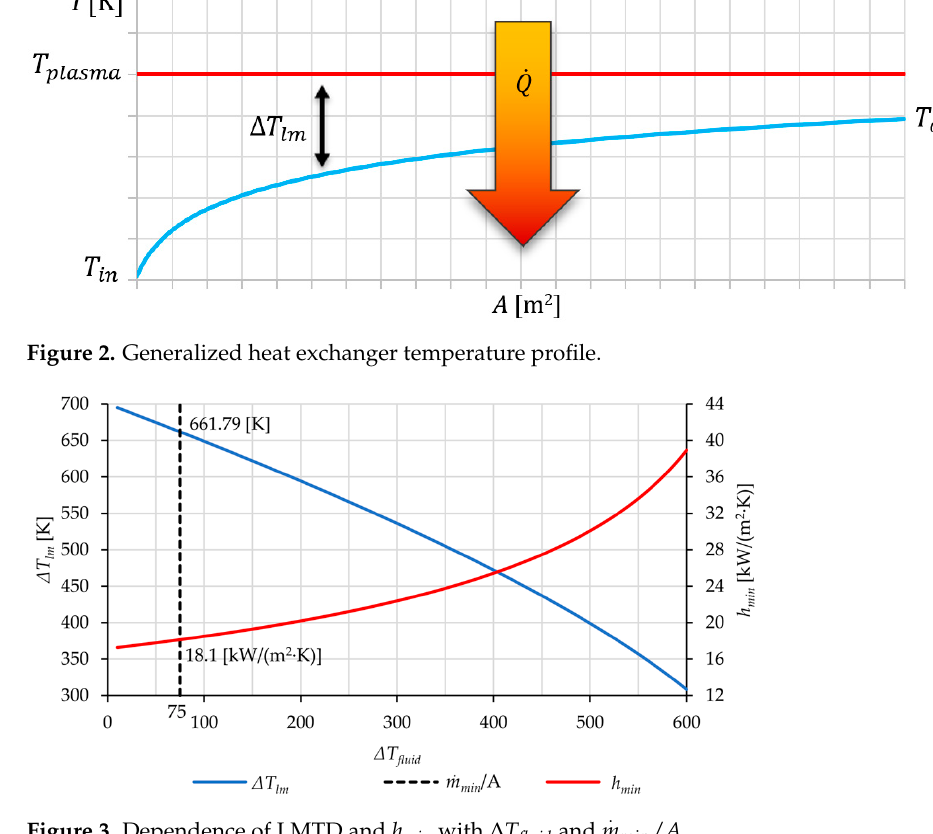
Figure 3. Dependence of LMTD and h min with Δ T fluid and m ̇ min /A .